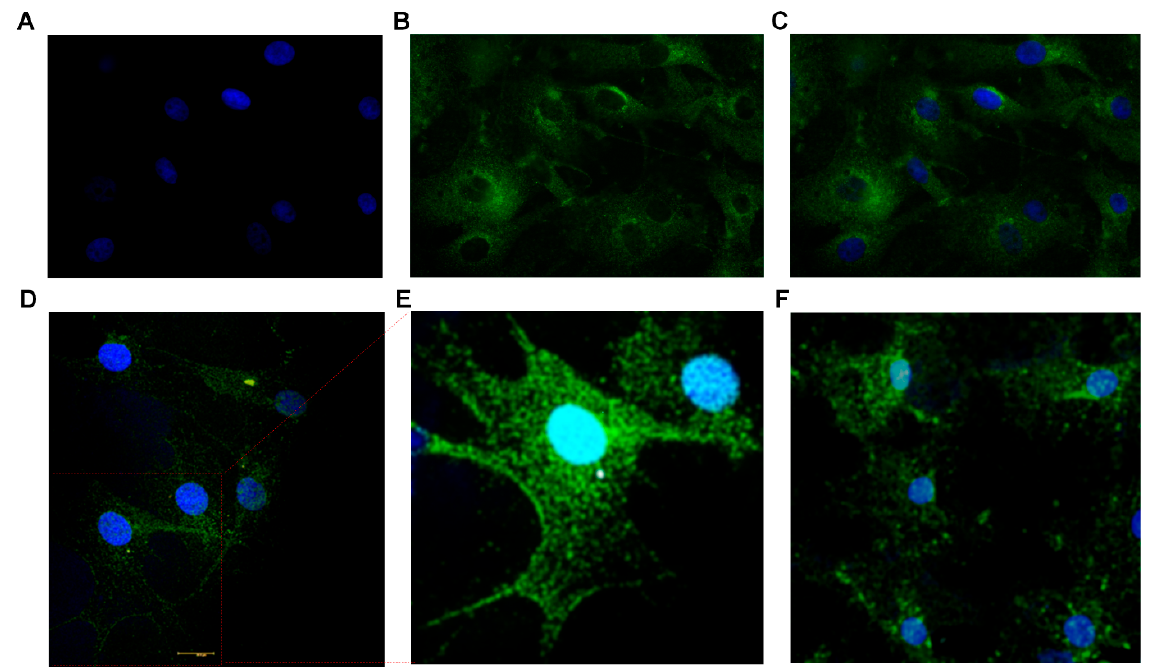
Figure 4. Immunocytochemistry studies demonstrating expression of taste-specific protein markers in cultured BTBCs. ( A–C ) Confocal images of cultured BTBCs expressing α -gustducin; ( A ) DAPI stained nucleus (blue), ( B ) Alexa Fluor 488 staining of the protein α -gustducin and ( C ) combined pictures. ( D ) PLC β 2 expressing cells and ( E ) the inset displays magnified view of the region on the red box; and ( F ) cells expressing bitter receptor T2R7.